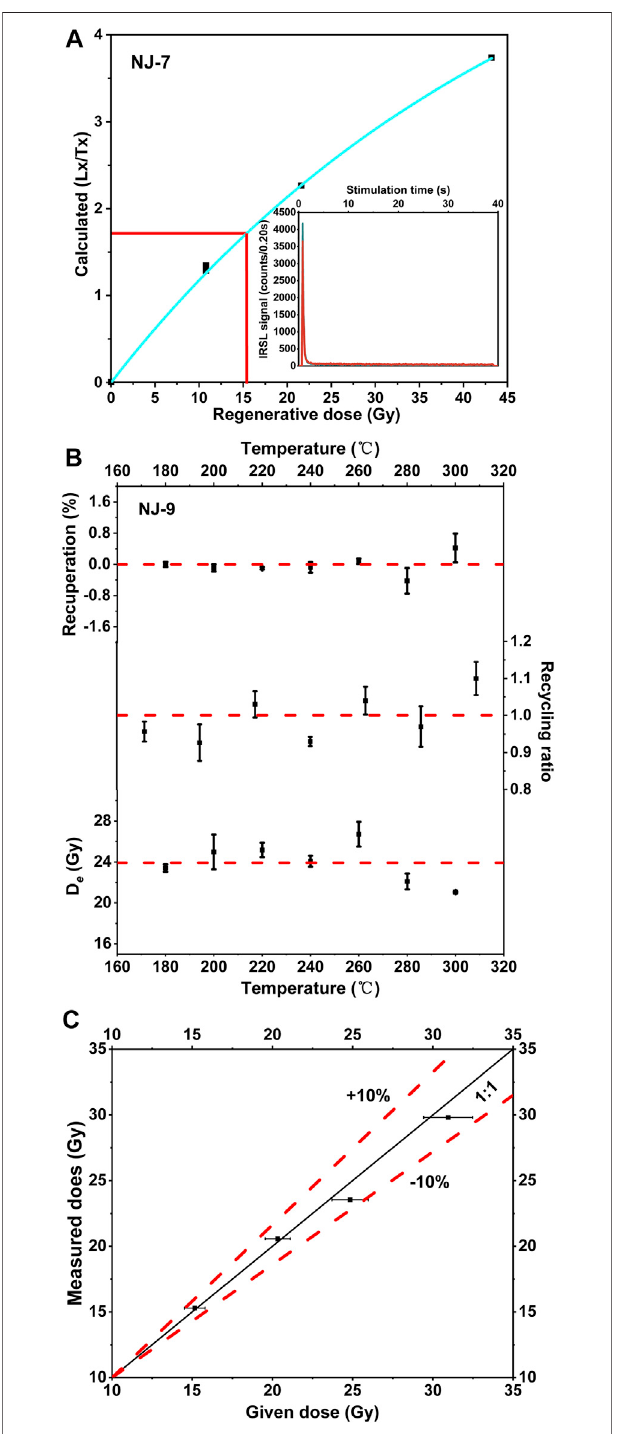
FIGURE3| OSLcharacteristicsforsamples,NJsection. (A) Growthand decay (inset) curves for sample NJ-7. (B) Preheat plateau tests (D e ) at sample NJ-9 showing a plateau between 180 and 300 ° C. (C) Dose recovery test. Given doses versus measured doses for four randomly selected samples.Thesolidblacklineistheslopeofunity,wheretheratiois100%,and the two red dashed lines indicate 10% above and below the line. Error bars represent one standard